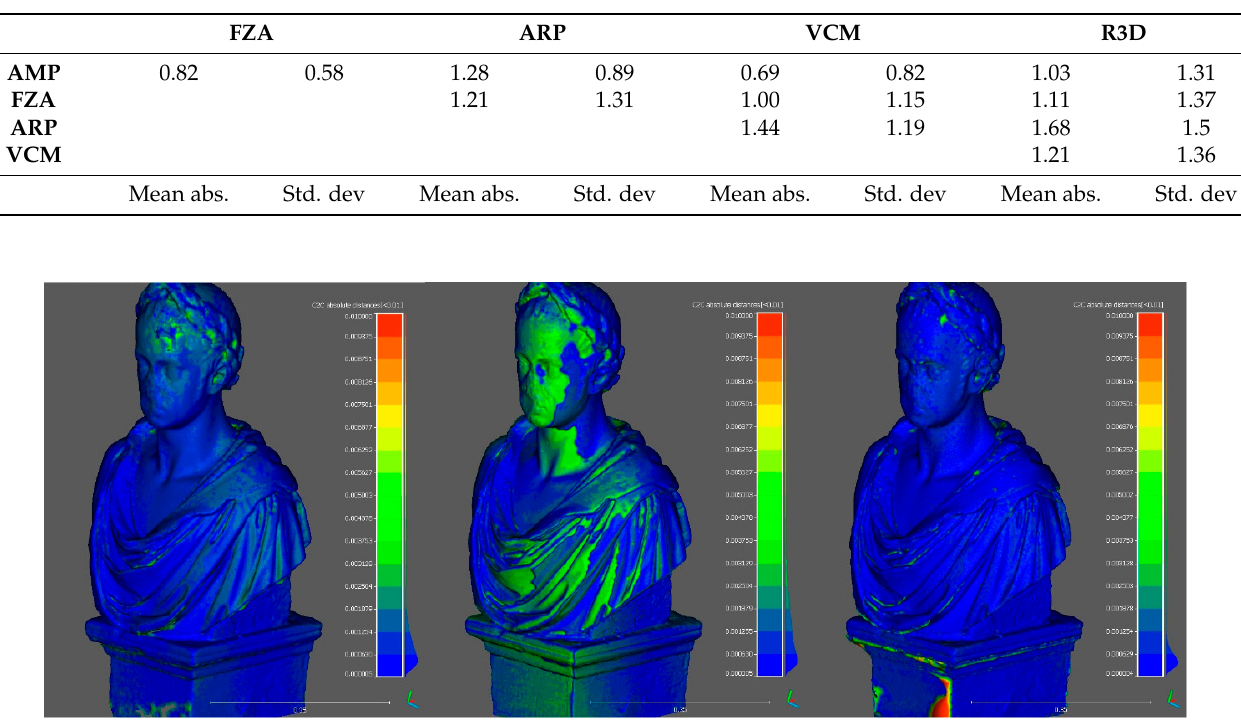
Table 14. Hausdorff distances between photogrammetric models for the small sculpture case study—datasets 7–9 (distances in